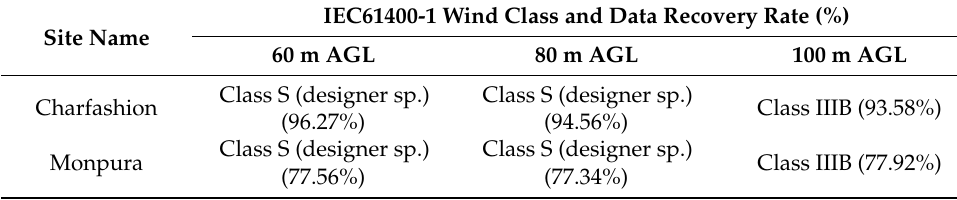
Table 12. Wind class of the selected microsites as per IEC 61400-1-2.